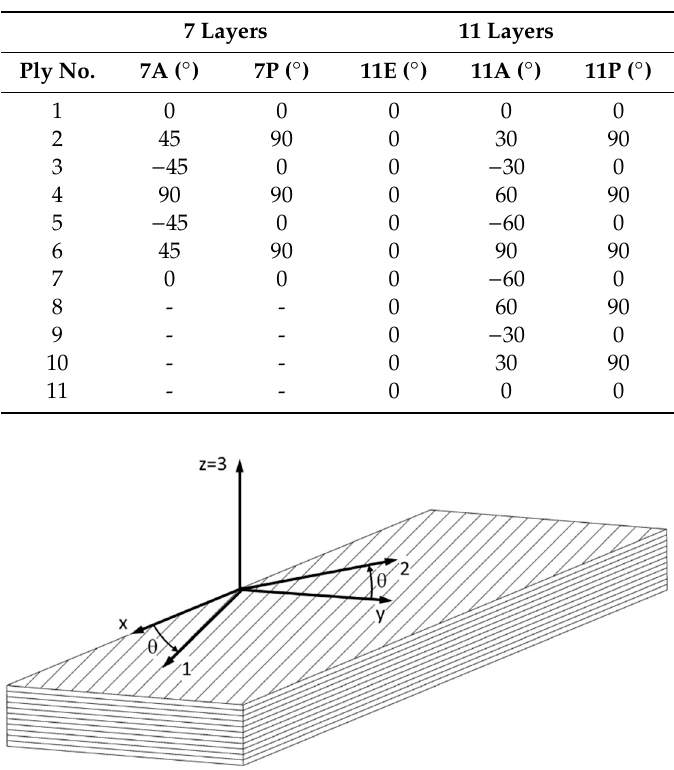
Table 1. Tissue orientations of individual layers for 7- and 11-layer beech veneer plywood.